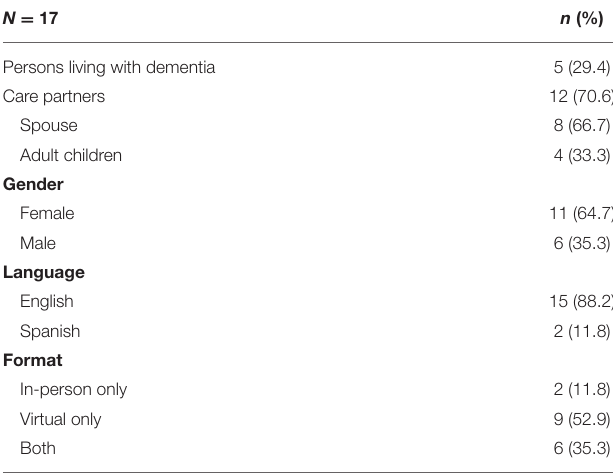
TABLE 1 | Participant demographic